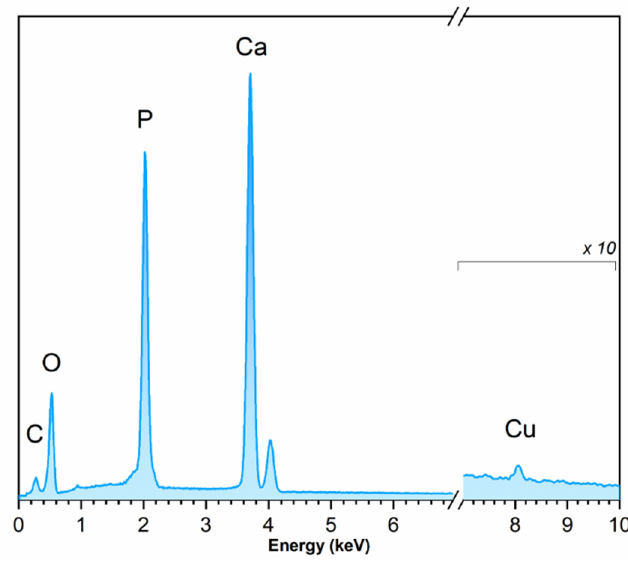
Figure 5. EDS spectrum of nHAp doped with 1 mol% Cu 2+ after heat treatment at 400 °C.